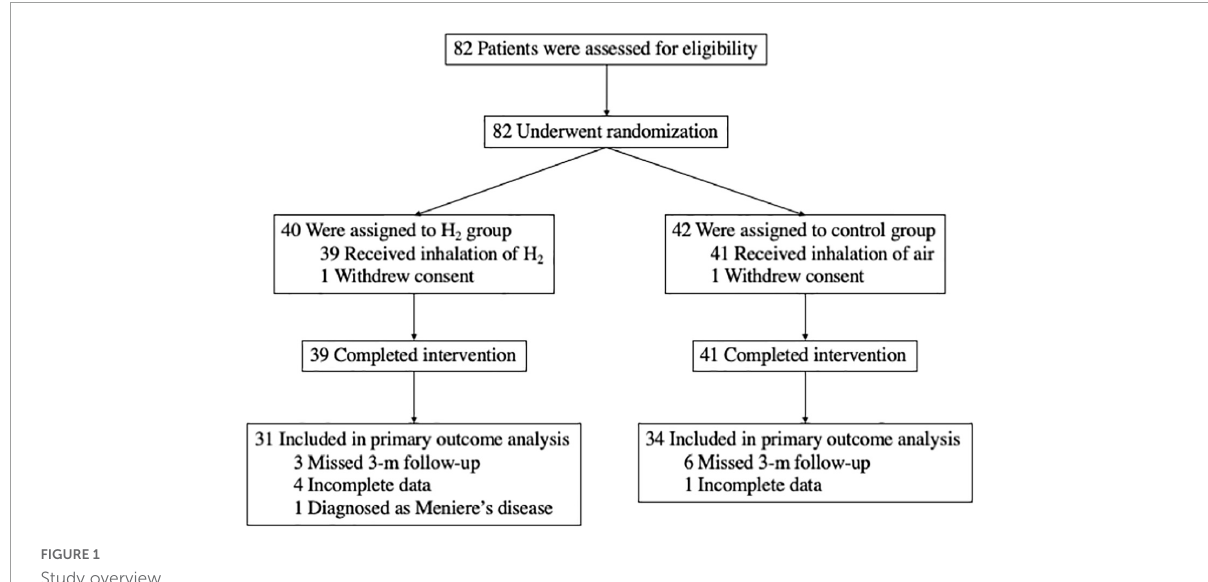
FIGURE1 Study overview.